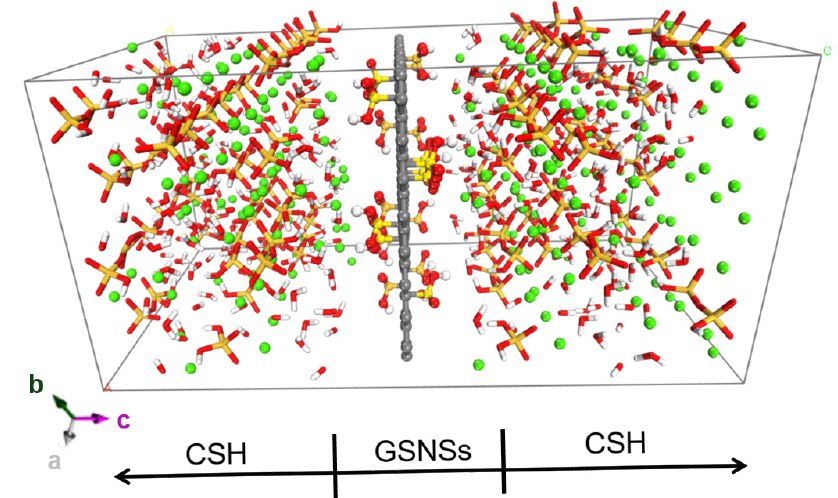
Figure 4. Molecular dynamics model of CSH/GSNSs composition, with lattice parameters a = 21.6 Å, b = 22.52 Å, c = 44 Å, and α = β = γ = 90° and periodic boundaries implemented in x, y, and z direction. The pristine graphite unit cell with lattice parameters a = 2.46 Å, b = 4.26 Å, c = 3.4 Å, and α = β = γ = 90° was replicated eight times along a-axis and five times along b-axis to construct the graphitic sheet. Then the graphitic sheet was functionalized by sulfonated groups (–SO 3 H) to reach the oxidization rate of 5%.